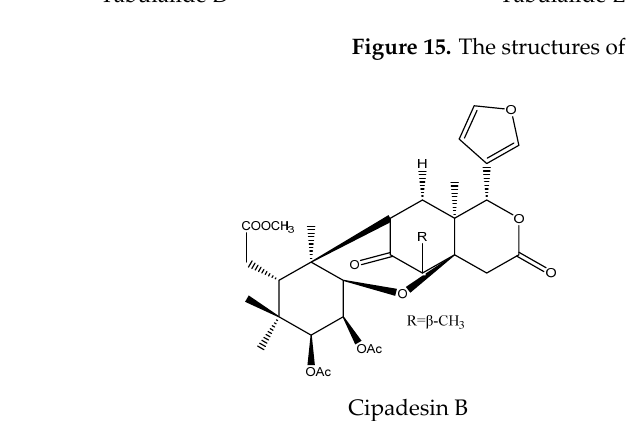
Figure 16. The structure of 10,11-linkage group chemical: cipadesin B.